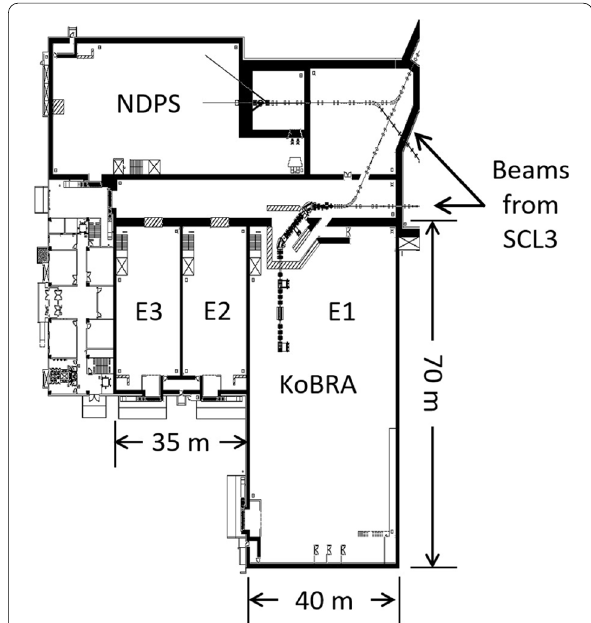
Fig. 11 Layout of the low-energy experimental halls at RAON. Presently, the two rooms are used for KoBRA and NDPS, respectively,